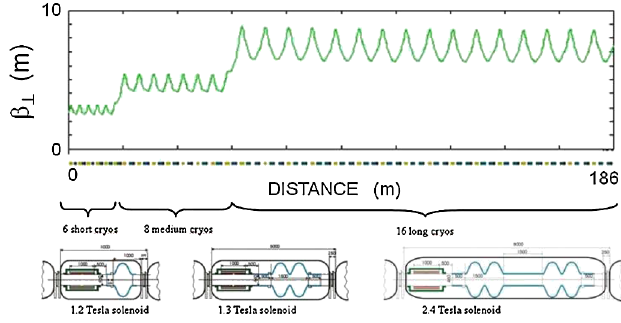
FIG. 7. (Color) Top: Transverse optics of the linac—uniform periodic focusing with six short, eight medium, and 16 long cryomodules. Below: Layout of the short, intermediate and long